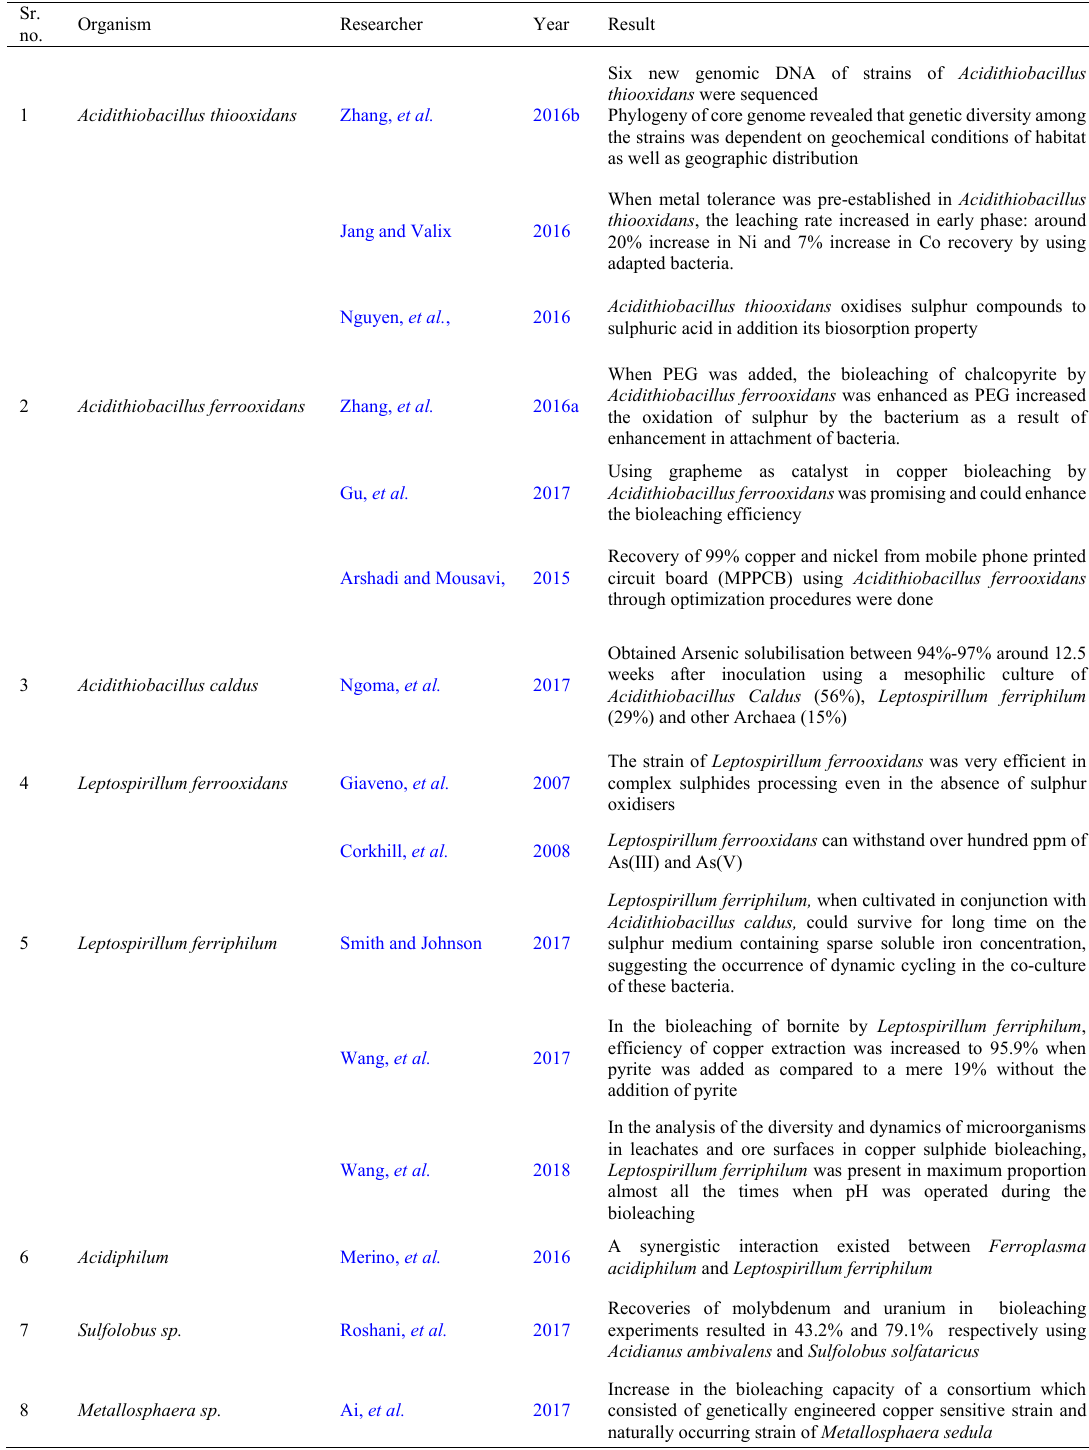
Table 2: Summary of results of recent research work carried out by various researchers on different bioleaching bacteria Sr. no.